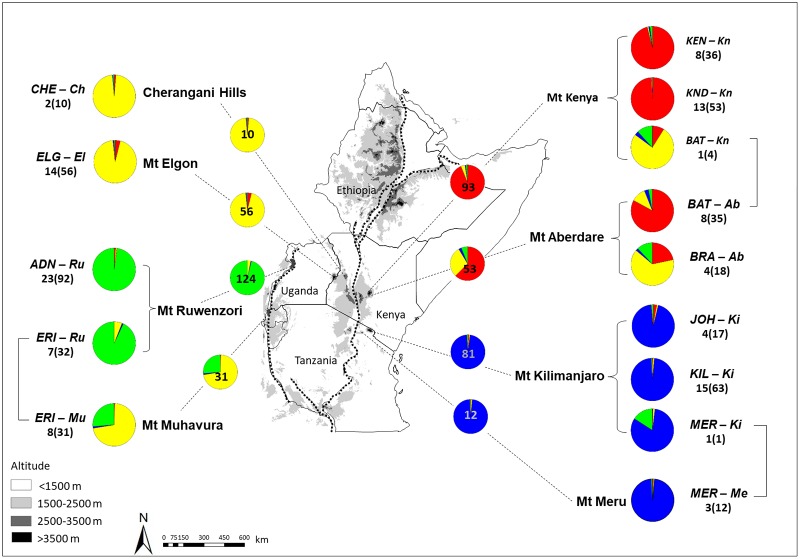
Sampling sites and main genetic structuring in Dendrosenecio based on the total AFLP dataset of 460 successfully analysed plants (109 populations representing all species and all but one of the subspecies accepted by Knox [24]).All species are represented with samples from all mountains from where they have been recorded, except that 1) KND has also been reported from Mt Aberdare, and 2) ERI has also been reported from some other Western Rift mountains located close to the two mountains investigated here. Colours represent the four main genetic groups inferred from STRUCTURE analyses, and the pie-charts show the proportion of admixture averaged over all individuals (corresponding to K = 4 in Fig 3). The pie-charts closest to the map are based on the total number of plants successfully analysed from each mountain (i.e. no taxonomic assignment). The pie-charts on the right and the left sides are based on taxonomic assignment according to morphology (ADN, D. adnivalis; BAT, D. battiscombei; BRA, D. brassiciformis; CHE, D. cheranganiensis; ELG, D. elgonensis; ERI, D. erici-rosenii; JOH, D. johnstonii; KEN, D. keniensis; KND, D. keniodendron; KIL, D. kilimanjari; MER, D. meruensis). The abbreviated species name is followed by abbreviated mountain name and number of populations (individual plants) successfully analysed. In three cases, plants originating from different mountains were assigned to the same species, indicated with brackets. The stippled lines represent the Great Rift Valley system.